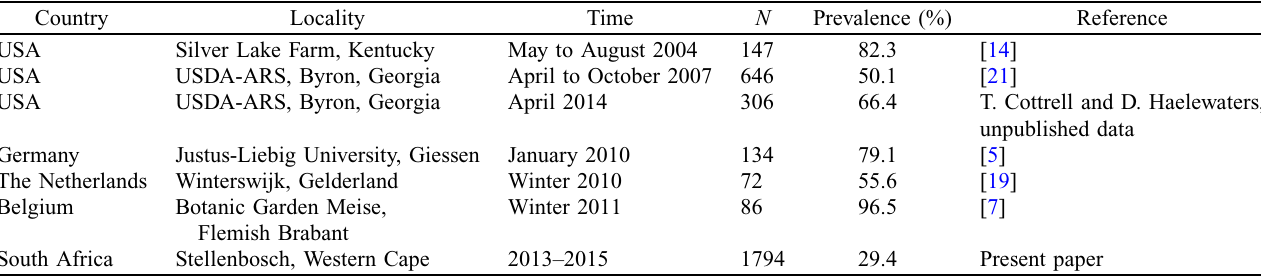
Table 2. Examples of studies on Hesperomyces virescens parasitizing Harmonia axyridis . The parasite prevalences (= number of infected individuals/total number of ladybirds sampled ( N )) show that H. axyridis has become the ‘‘main host’’ species in several well-studied